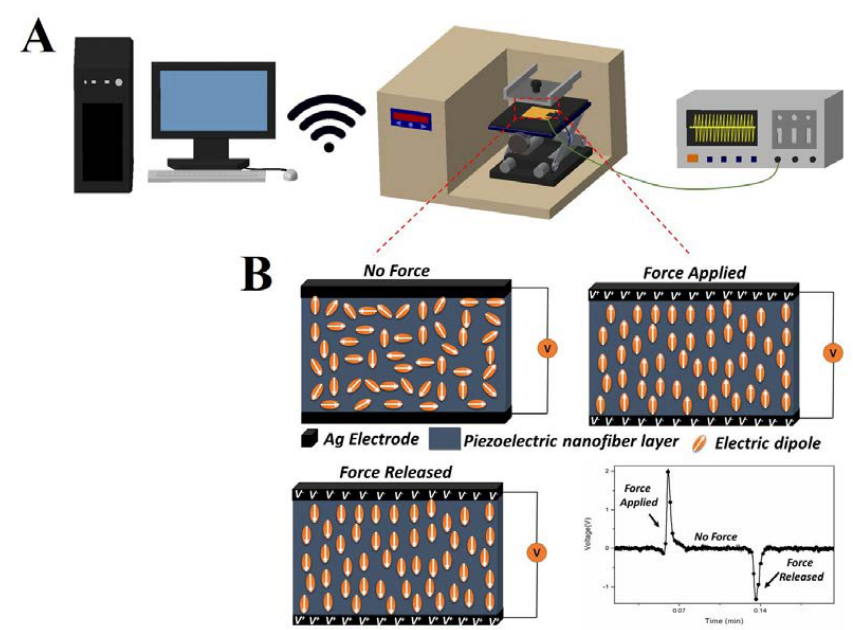
Figure 3. Schematic illustration showing. ( A ) the experimental set up for piezoelectricity measurement, ( B ) schematic illustration showing the working mechanism of the PGANF ferroelectric nanogenerator (FENG).